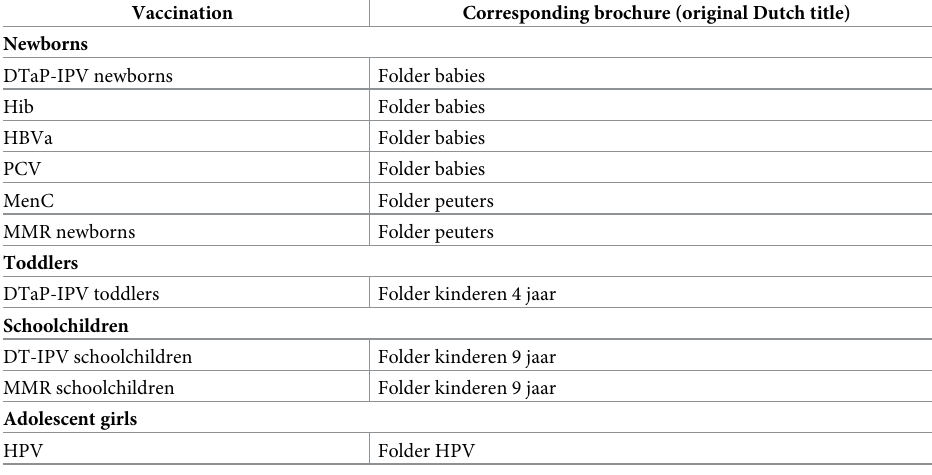
Table 1. Vaccinations and corresponding